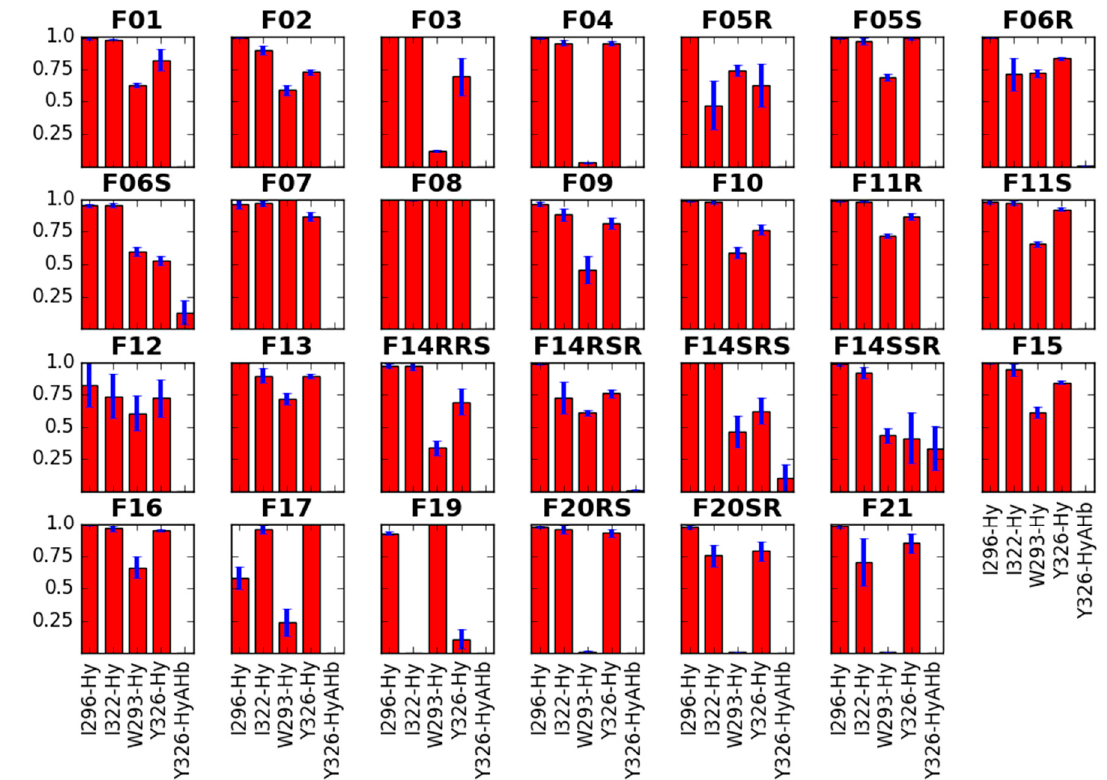
Figure 4. Interactions of the N-substituent with the receptor residues. Red bars represent the mean frequency of contacts with a particular residue, and blue bars show standard error of the mean. Data are collected from last 10 ns of production in 3 replicas. In x -axis label given is the residue’s name and number as well as type of the contact (Hb—hydrogen bond, Hy—hydrophobic, A—aromatic).